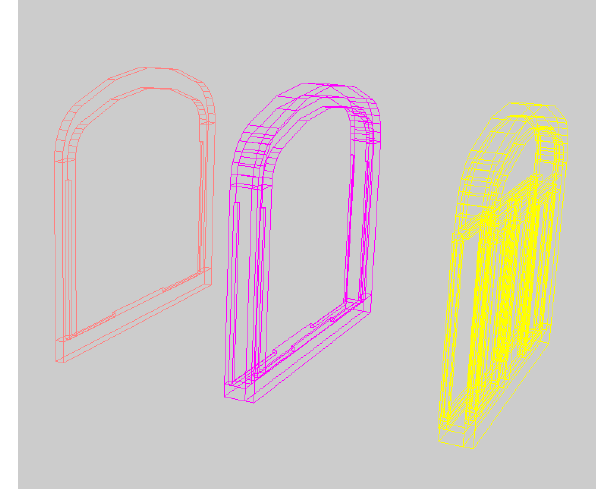
Figure 1 . Window in three different